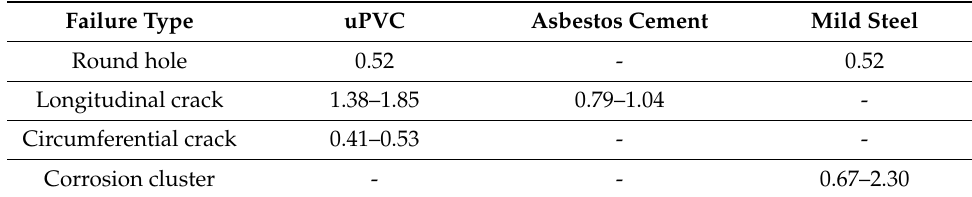
Table 3. Summary of leakage exponents N 1